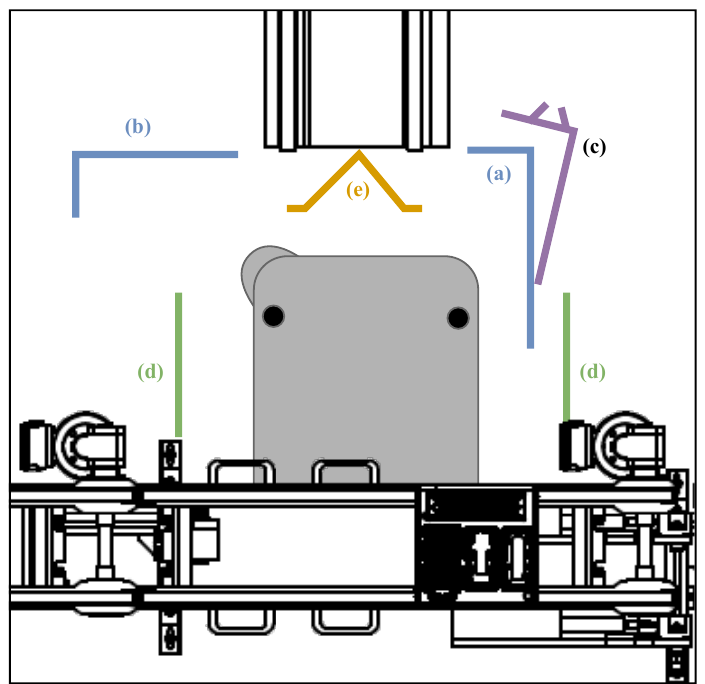
Figure 10. ( a ) L-marker, good position; ( b ) L-marker, problematic position; ( c ) VL-marker; ( d ) bar- markers; ( e )